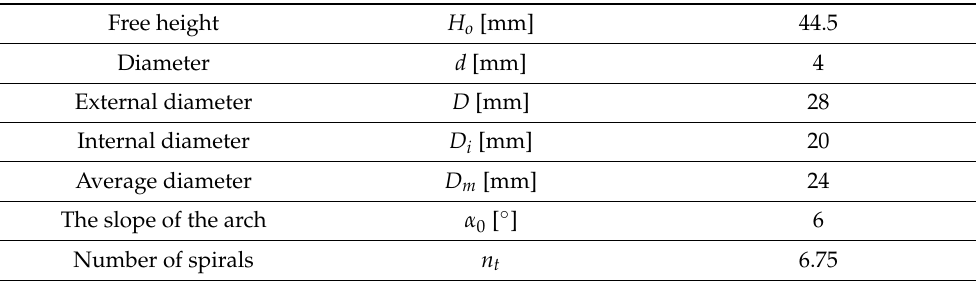
Table 3. Constructive characteristics of the valve